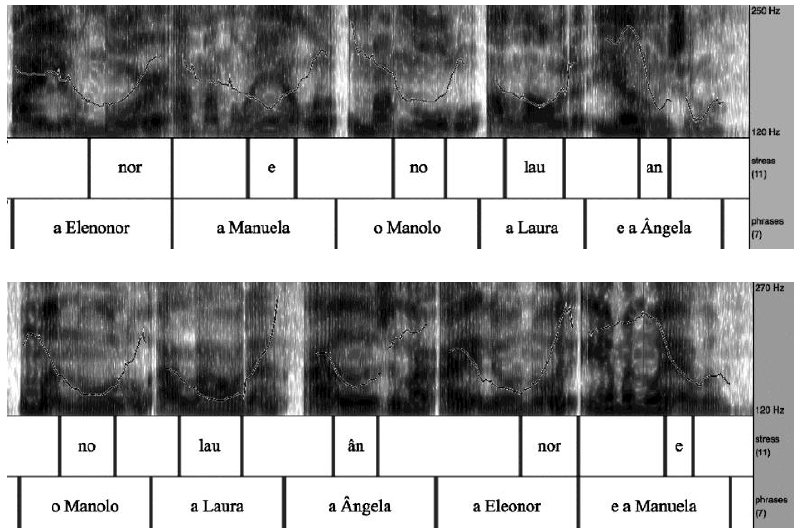
Figure 5. Renditions of lists by speaker 3 (above) and speaker 4